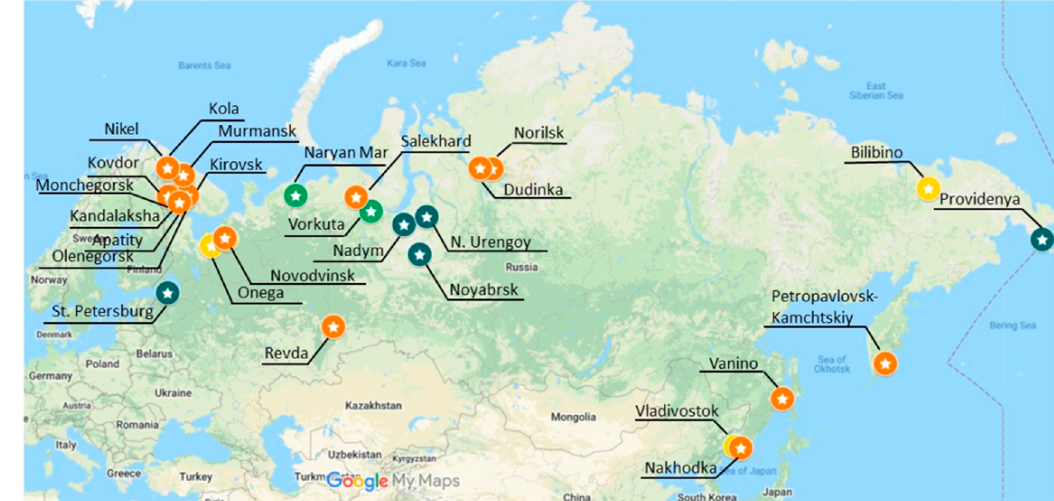
Figure 5. Spatial distribution of eco ‐ efficiency of the cities along the NSR. Note: the dark green, green, yellow, and orange markers in Figure 5 indicate that the associated cities are fully, highly, averagely, and poorly eco ‐ efficient, respectively.